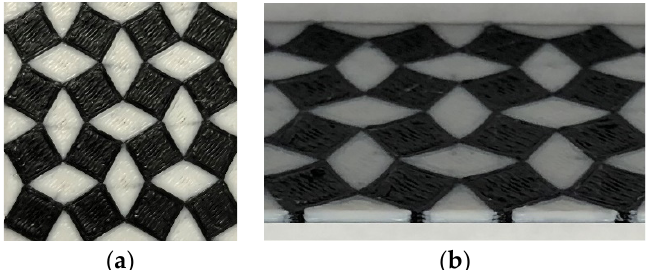
Figure 3. Architected plate fabricated by multi-material additive manufacturing: ( a ) top view ( b ) inclined view.